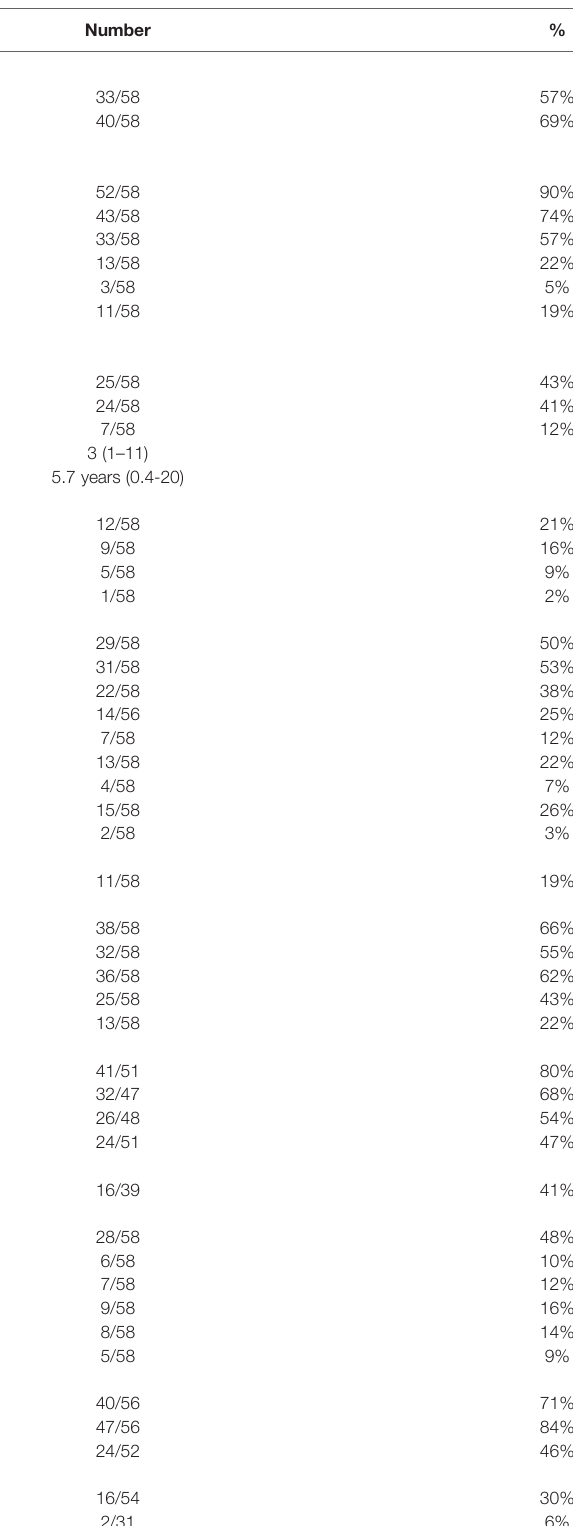
TABLE 1 | Summary of clinical and laboratory